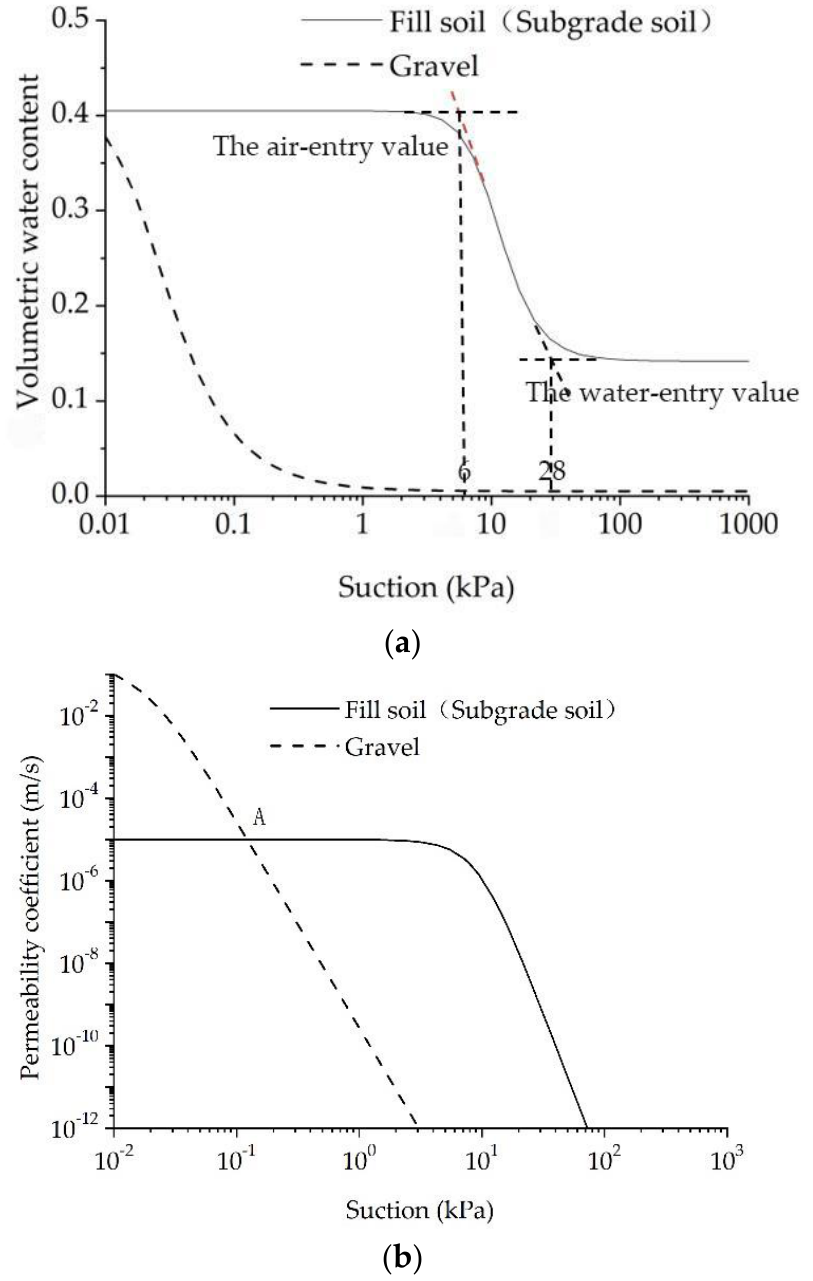
Figure 2. ( a ) Soil water characteristic curves and ( b ) permeability function of soils used in the subgrade. In order to avoid the decrease in soil strength due to the presence of rainfall, this paper proposes to add a capillary barrier on the fill slope to protect the subgrade. The fine-grained soil in the capillary barrier was filled with the soil near the expressway. Gravel or sand was used as the coarse-grained soil. The fill slope soil from the surface to bottom was the fill near the expressway, gravel, and subgrade soil. Figure 2 shows the soil water characteristic curves and permeability coefficient curves of the two soils. The unsaturated permeability coefficients were estimated using the Mualem model